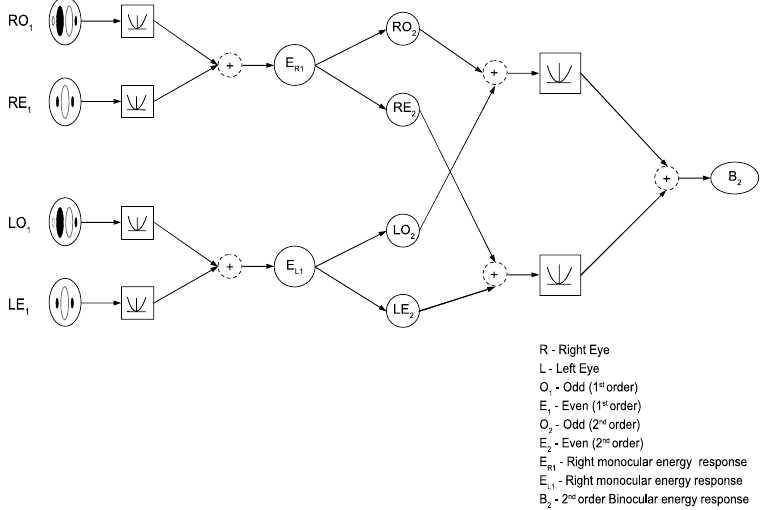
Figure 4. A second-order binocular energy model. The monocular energy responses are calculated separately for each eye. The first-order filtering responses are squared and summed, to produce monocular energy responses ( E R 1 and E L 1 ). This forms the input to the second order filters where the pairs of monocular filters are summed, squared and combined to calculate the second-order binocular energy